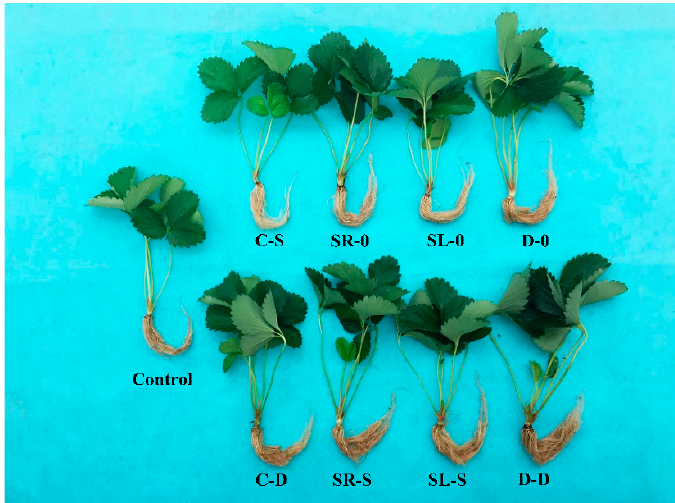
Figure 1. Propagated strawberry daughter plants as a ff ected by Si. The letters before the hyphen indicate Si being applied before the cutting propagation, while the letters after the hyphen represent Si being supplied after the cutting propagation. C, control; SR, spraying the runners; SL, spraying the leaves; D, drenching the roots; 0, spraying distilled water; S, spraying the leaves.